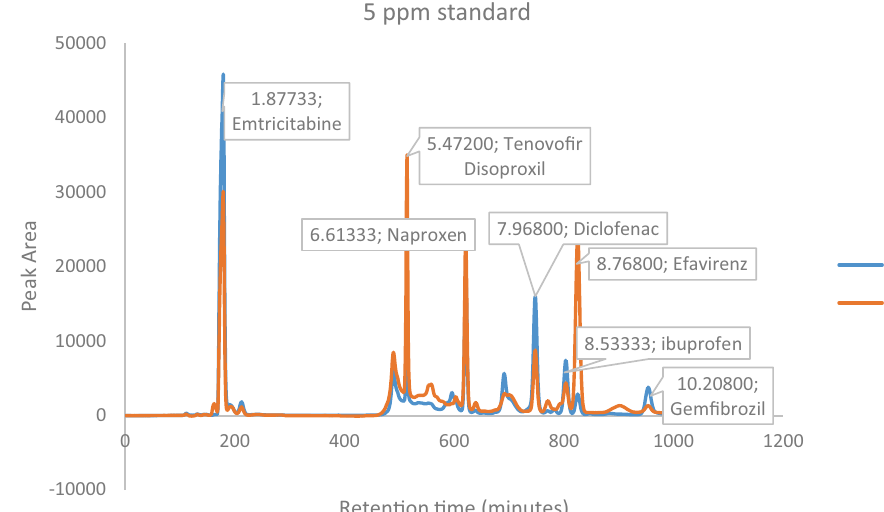
Fig. 1 Retention time and peak area chromatogram